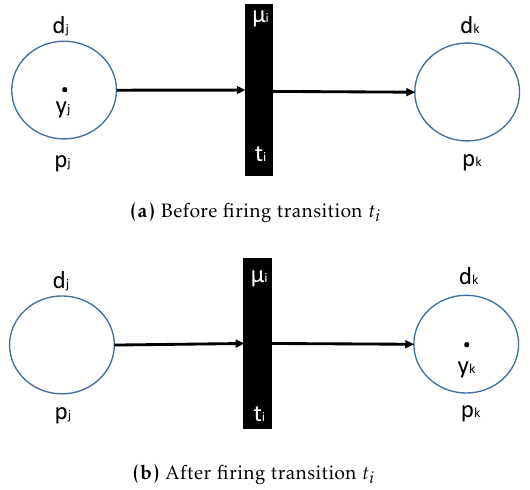
Figure 1. Firing a fuzzy petri net